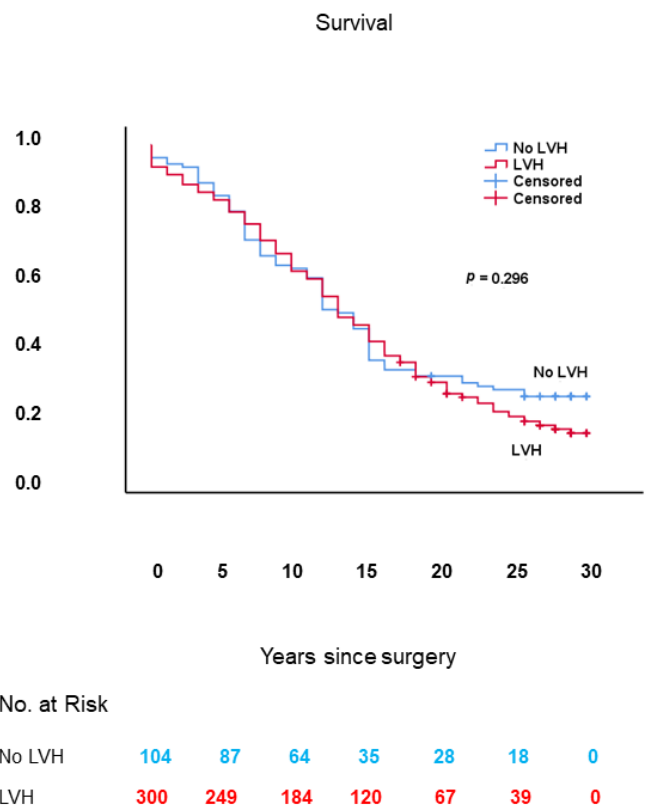
Figure 3. Kaplan–Meier survival curves, from date of surgery, of patients with vs. those without LVH. LVH: left ventricular hypertrophy.